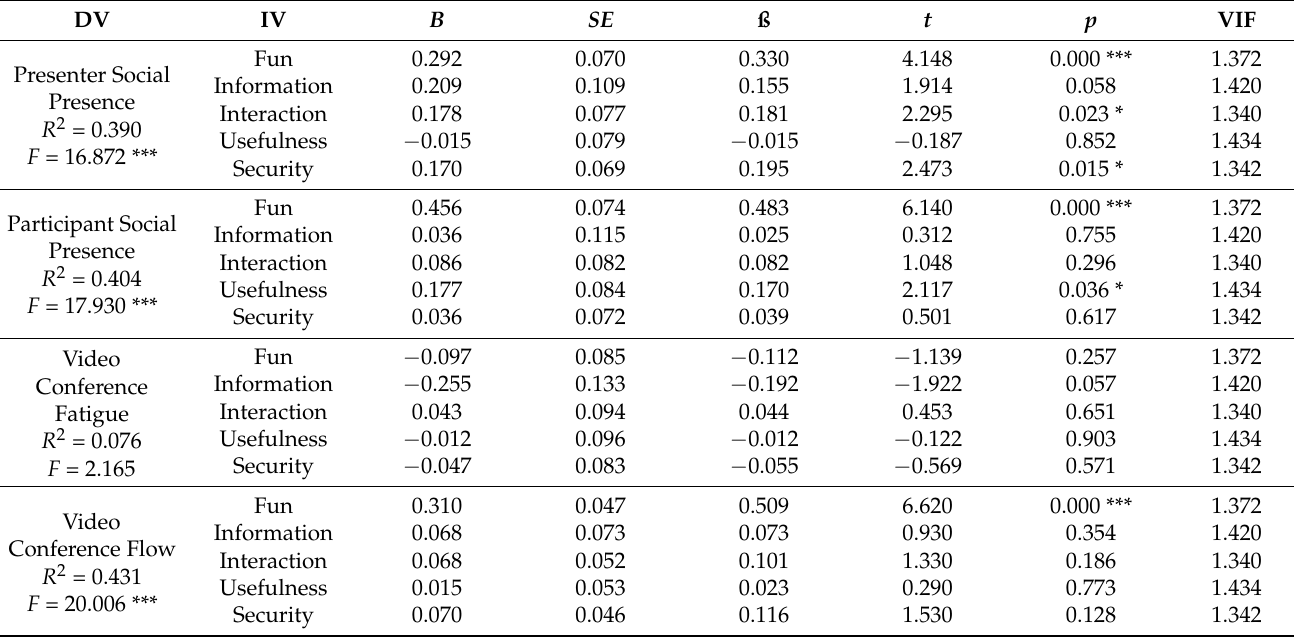
Table 8. Results of multiple regression using video conference quality to predict social presence, fatigue, and flow.